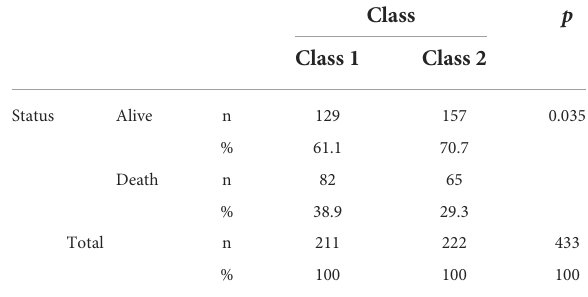
TABLE 4 Survival status distributions of latent